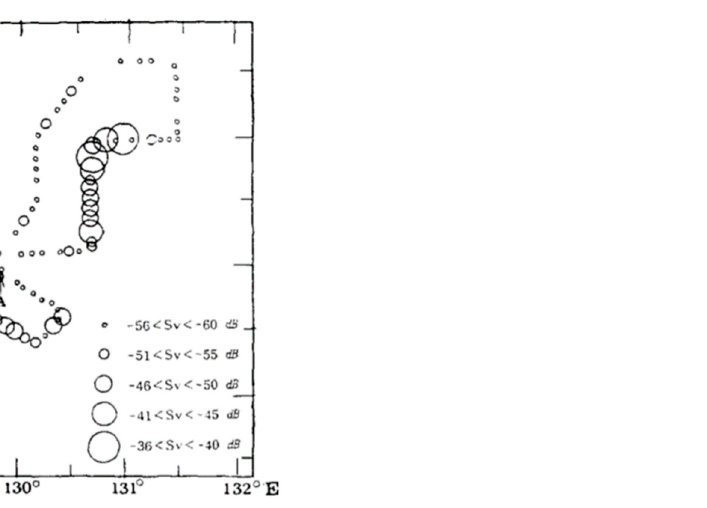
Figure 13. Spatiotemporal distribution of anchovy.